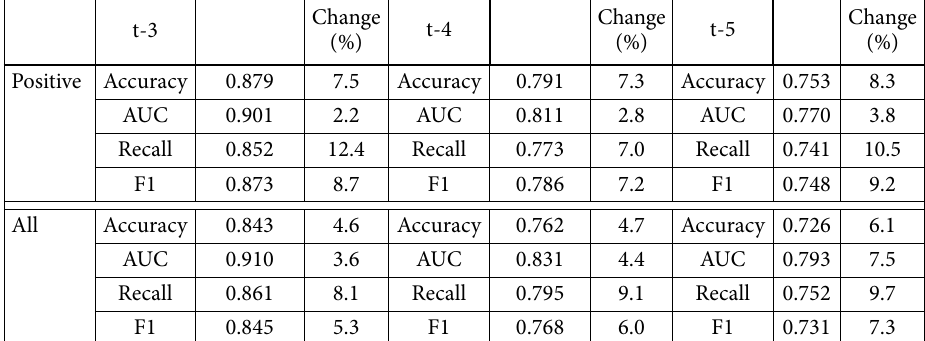
Table 9. Experimental results of feature selection (Positive companies and all